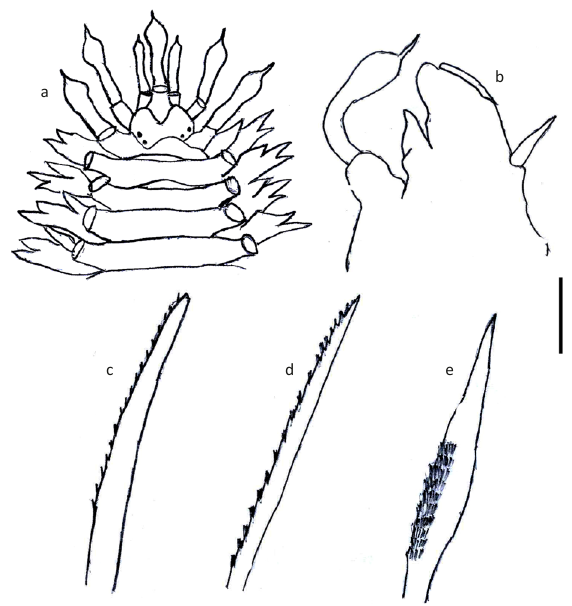
Figure 1. Symbiotic polychaete G. clavigera Schmarda, 1861 A - anterior end (dorsal view); B - cirrigeous parapodium (posterior view); C - notosetae; D - neurosetae (upper); E - same (middle). Scale: A = 1mm; B = 0.5mm; C–E